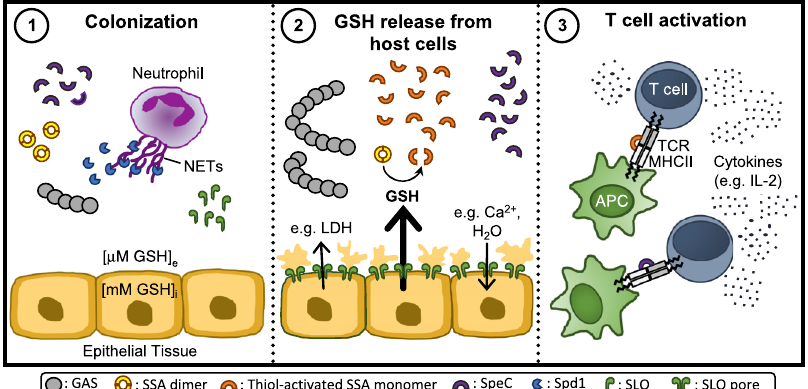
Fig. 5 Proposed mechanistic model outlining inter-relationships between SLO mediated cytotoxicity towards epithelial cells and SSA superantigen potency. ( 1 ) During initial bacterial colonization, GAS secretes the DNase Spd1 to escape neutrophil clearance, allowing GAS to establish infection. ( 2 ) As infection progresses, SLO binds to host cell membranes and then oligomerizes to form large pores which induces the release of lactate dehydrogenase (LDH) and GSH from perforated host cells as well as cation in fl ux 71, 72 . Glutathione exists at a much higher concentration in the intracellular compartment (GSH i ) than the extracellular space (GSH e ) (~1000-fold) causing a signi fi cant difference in redox potential across the plasma membrane of eukaryotic cells. This gradient makes the extracellular and intracellular areas, respectively, oxidative and reductive. GSH ef fl ux from perforated cells serves as a stimulus for SSA release, reduces SSA dimers and activates SSA monomers. ( 3 ) Thiol-activated SSA, in conjunction with other superantigens like SpeC, then cross-links major histocompatibility complex II molecules on antigen-presenting cells (APCs) and the variable region of the β -chain of T-cell receptor (TCR) to induce an overwhelming T-cell response with uncontrolled cytokine